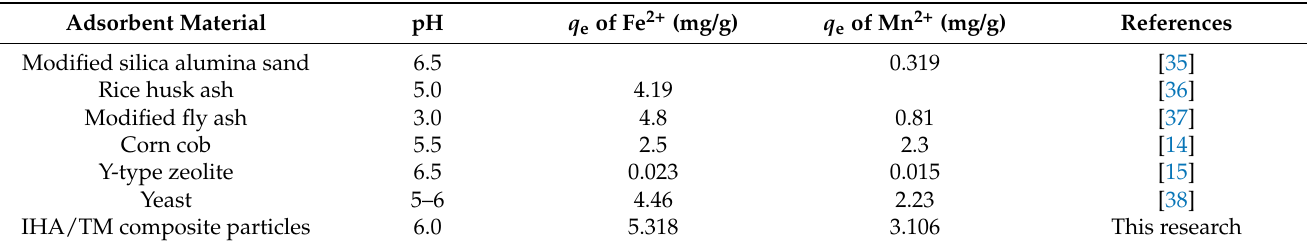
Table 1. Comparison of the adsorption effect of different adsorption materials on iron and manganese